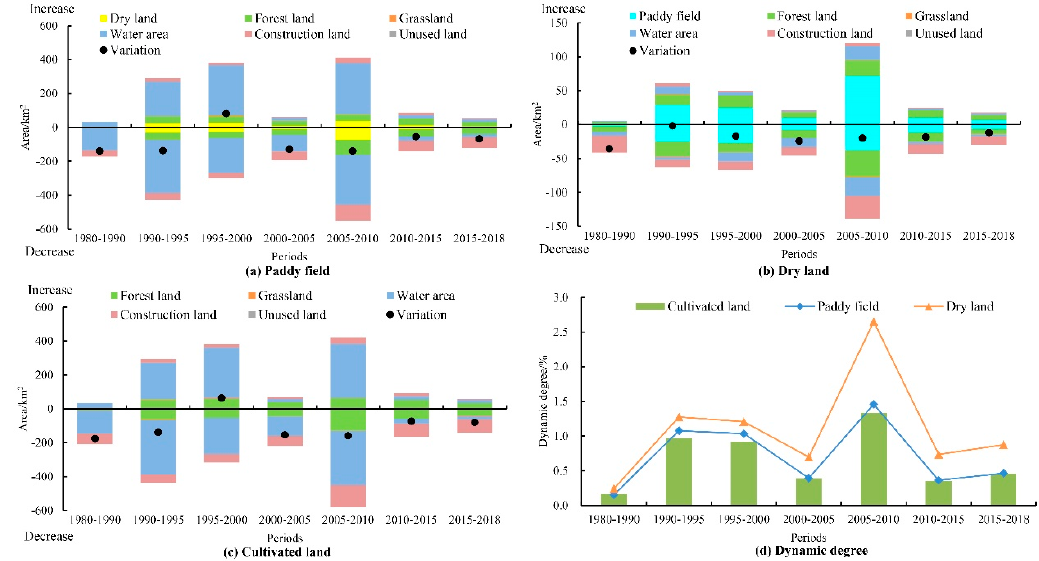
Figure 4. Dynamic degree of cultivated land change in 1980–2018. ( a ) conversion between paddy field and other land types; ( b ) conversion between dry land and other land types; ( c ) conversion between cultivated land and other land types; ( d ) dynamic degree of cultivated land change.